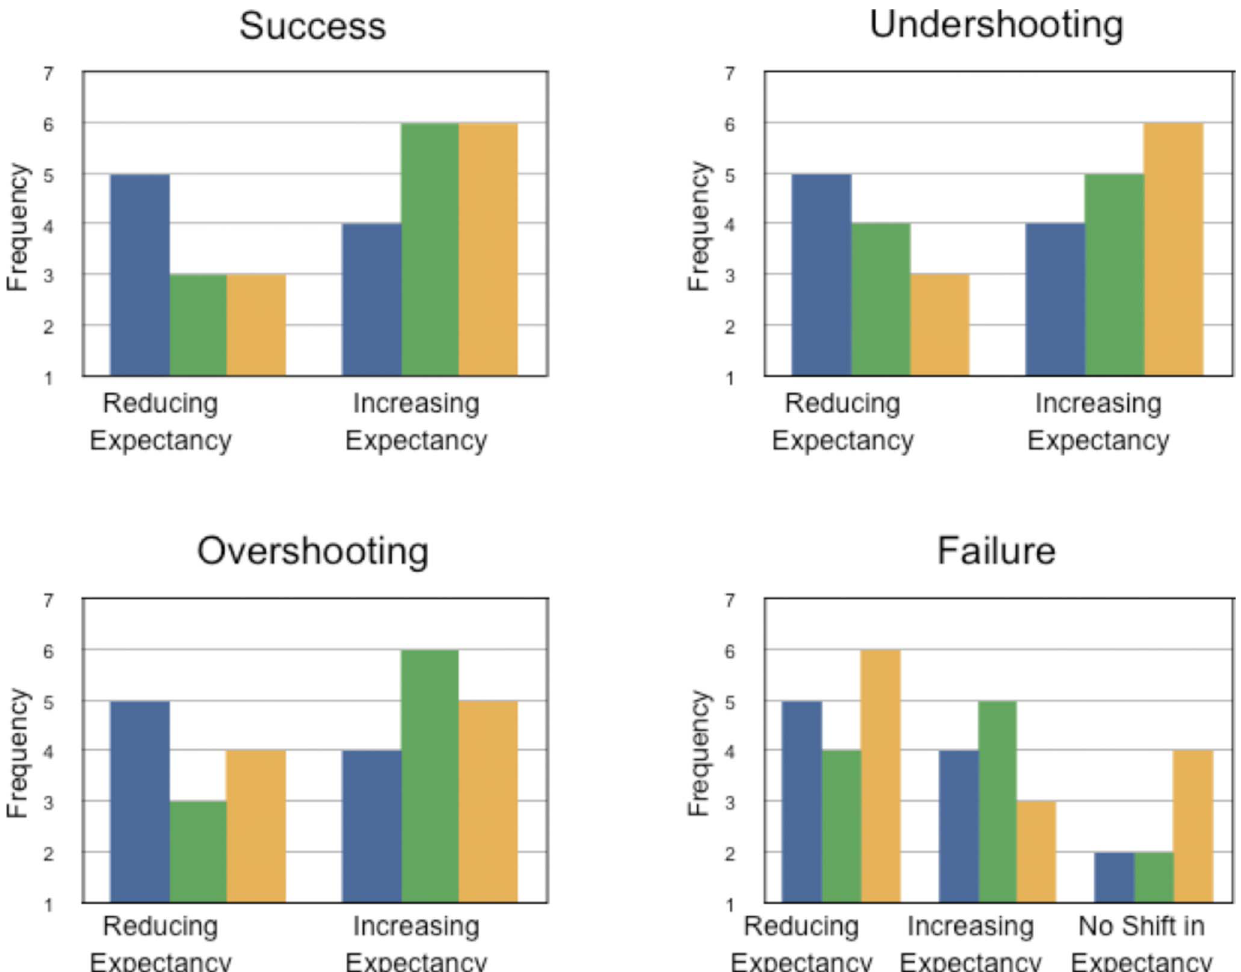
FIG. 3. (cid:1) Color (cid:2) Prototypical patterns of students’ initial expectations (cid:1) blue, first column (cid:2) , expectations after orientation (cid:1) green, second column (cid:2) , and experiences (cid:1) orange, third column (cid:2) .